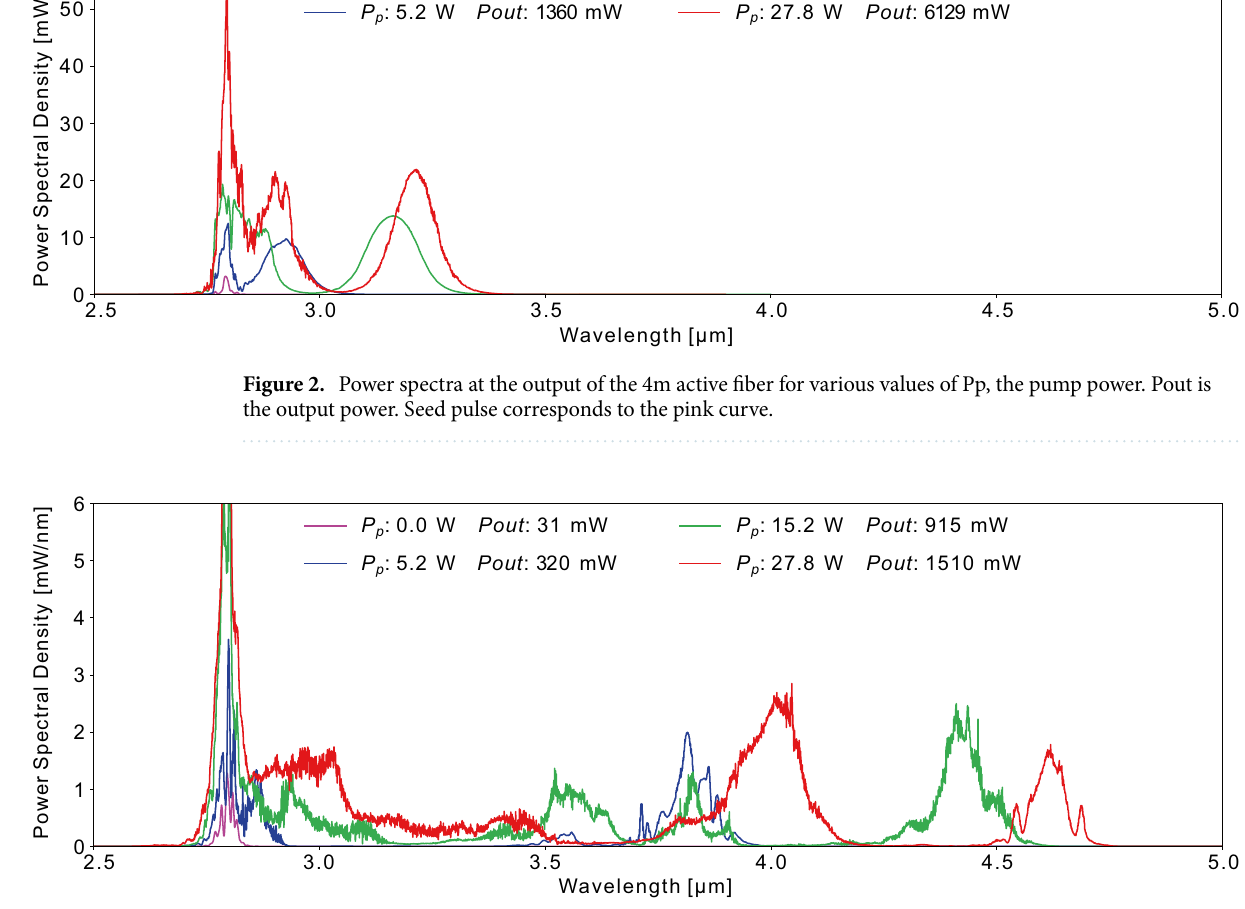
Figure 3. Evolution of the power spectra at the output of the passive 20 m long InF 3 fiber for increasing values of